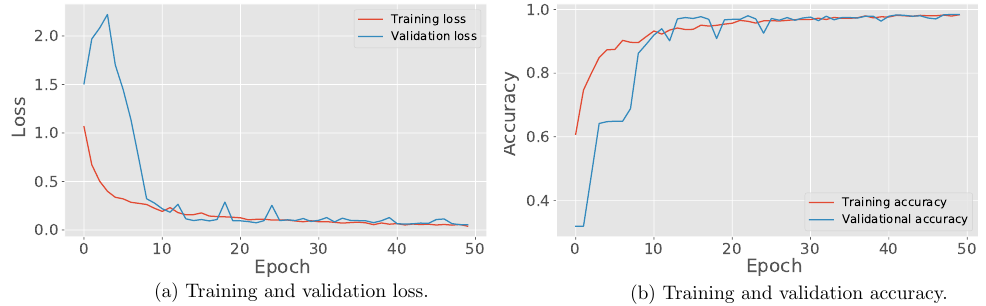
Figure 13. CNN loss ( a ) and accuracy ( b ) per